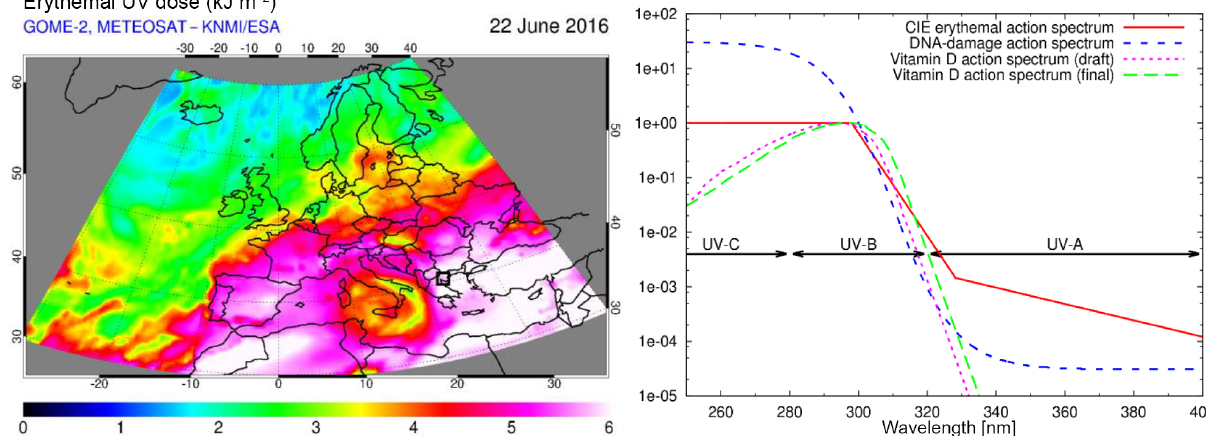
Figure 1. Left panel: erythemal UV dose over Europe on 22 June 2016. Thessaloniki, indicated by a black square, had an almost cloud-free day with an erythemal UV dose of 5.77kJm − 2 and an erythemal UV index of 10.1. Right panel: action spectra of erythema (red solid line), generalized DNA damage (blue dashed line), and production of vitamin D (magenta dotted line: draft version as used within TEMIS (Holick et al., 2005); green dashed line: final version as adopted by the CIE (Bouillon et al.,